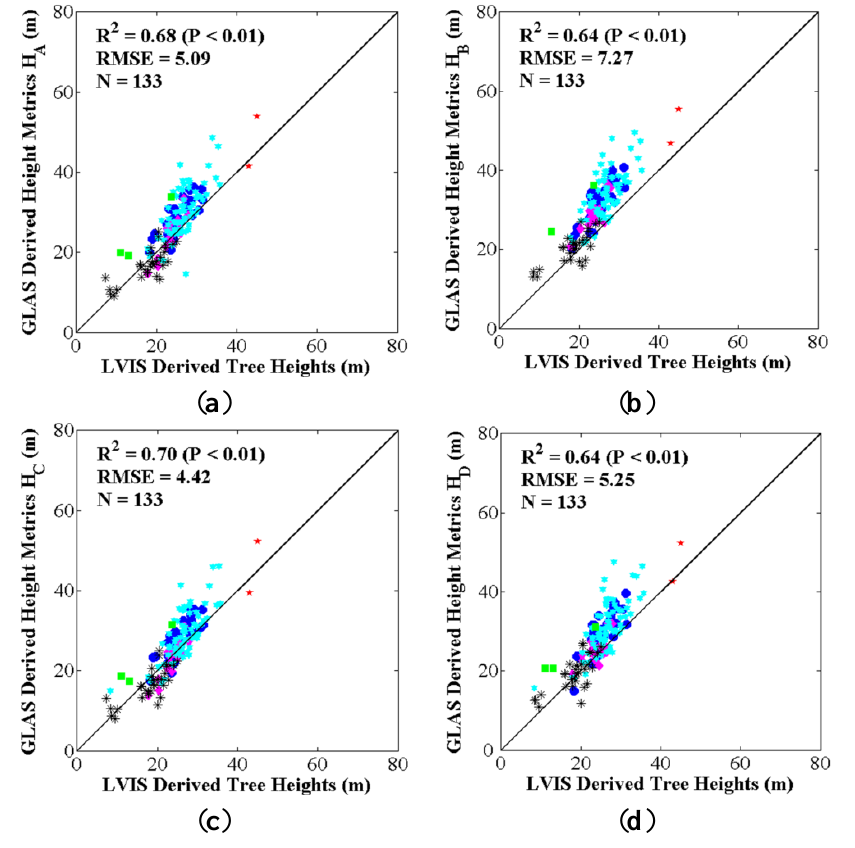
Figure 5. Comparison of five GLAS-derived metrics ( a – e , H heights. The slope of the terrain in all cases is less than or equal to 5°. Comparisons for other topographic conditions (slope > 5°) are shown in Figure S7 and